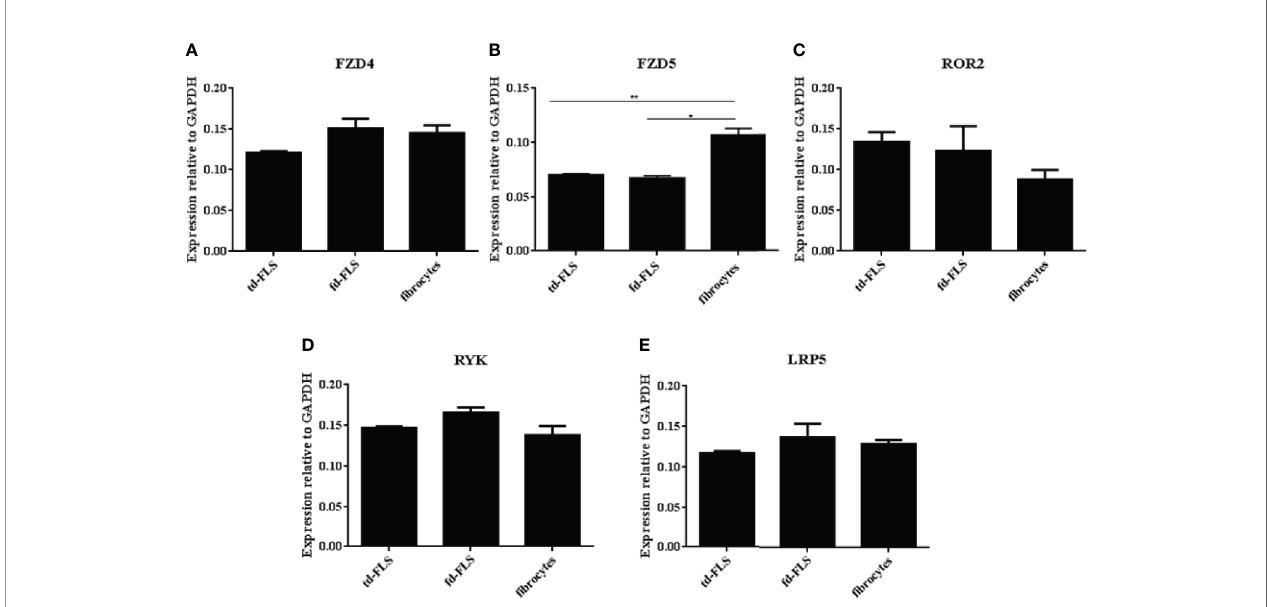
FIGURE 4 | Expression of Wnt5a receptors and coreceptors in td-FLS, fd-FLS and fi brocytes during RA: Relative mRNA levels of Fzd4, Ror2, Ryk and LRP5 in the three cell types: No difference was detected between the cells using qPCR analysis (A, C – E) . Fzd5 was highly expressed in fi brocytes compared to td-FLS and fd- FLS (n=3-4) (B) . Results are shown as the mean ± SD *Statistically signi fi cant difference p < 0.05, **statistically signi fi cant difference p < 0.01, using non-parametric Kruskal Wallis test with a post hoc test.